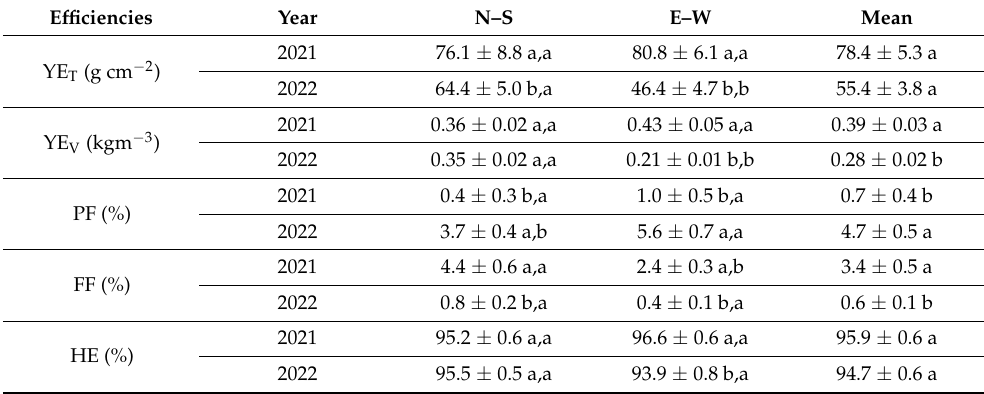
Table 6. Yield and harvesting efficiencies for 2021 and 2022, in E–W and N–S row orientations. The first letters denote statistical differences among years for an orientation; the second letters denote statistical differences between orientations for a year ( p = 0.05; SNK